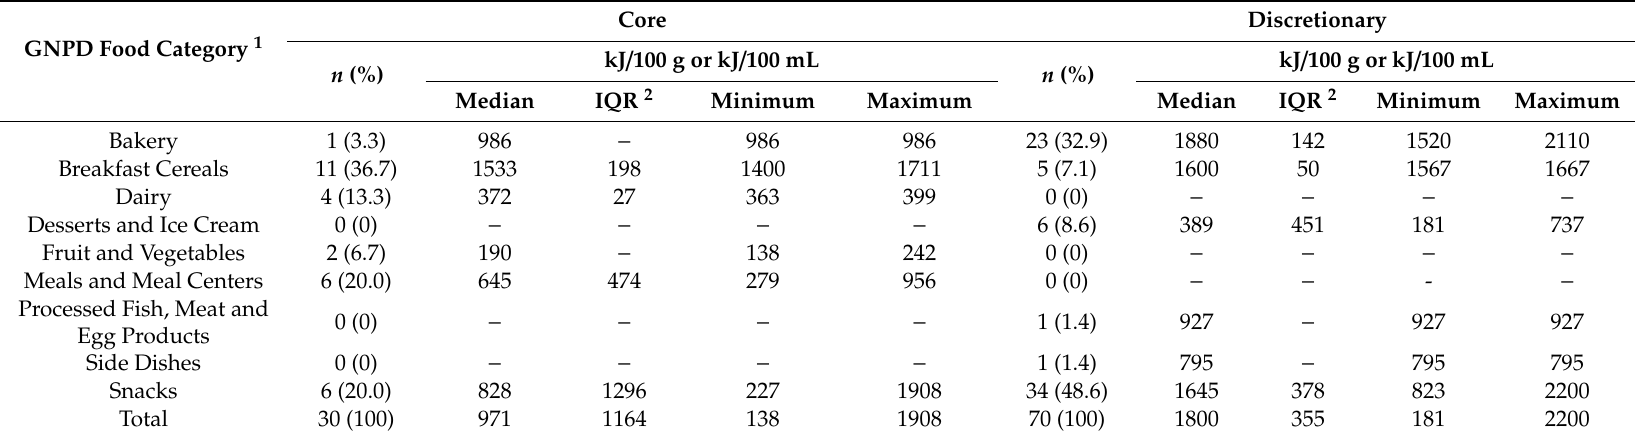
Table 4. The energy density of the core and discretionary products displaying the Health Star Ratings (HSRs) by Global New Products Database (GNPD) food category.